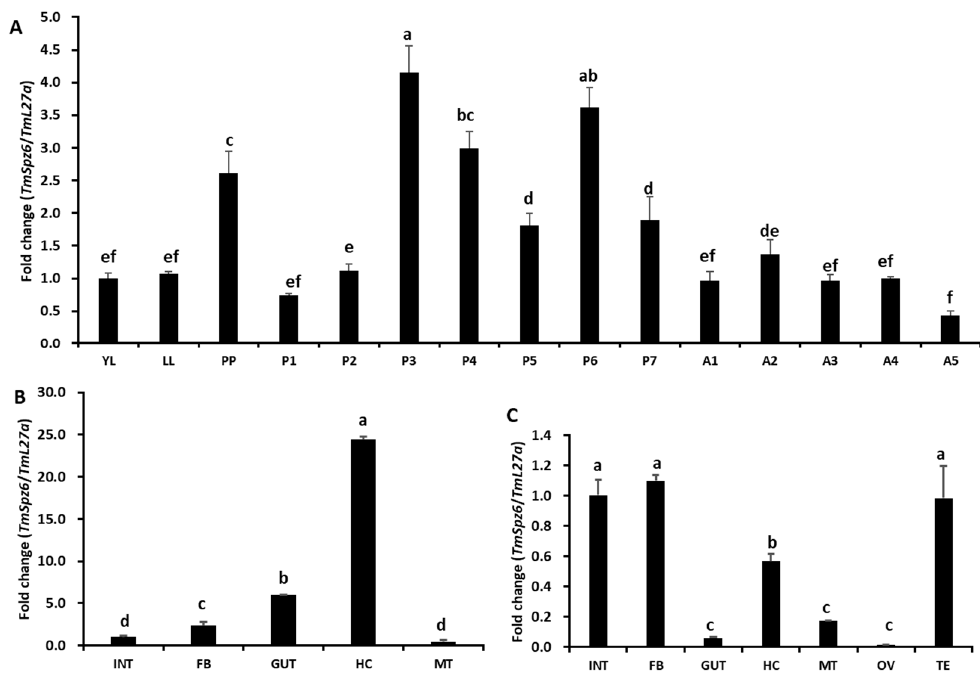
Figure 3. Developmental stage- and tissue-specific expression patterns of the TmSpz6 gene in T. molitor. TmSpz6 expression patterns across the developmental stages of T. molitor , including, young larvae (YL), late larvae (LL), pre-pupa (PP), 1–7-day-old pupae (P1–7), and 1–5-day-old adults (A1–5) were examined ( A ). For each sample, RNA extracted from 20 individuals was used to synthesis cDNA. The results indicate that TmSpz6 expression gradually increased from the young larval to pre-pupal stage. In the pupal stage, the highest expression was observed in 4-day-old pupae. In adults, there was no considerable di ff erence in expression in 2–5-day-old adults. The tissue-specific expression patterns of TmSpz6 were also assessed in late larvae ( B ) and 5-day-old adults ( C ). The hemocytes (HC), gut, fat body (FB), Malpighian tubules (MT), and integument (INT) (for late instar larvae and adults), as well as the testes (TE) and ovaries (OV) (for adults), were dissected and collected from 20 late larvae and 5-day-old adults. T. molitor 60S ribosomal protein L27a ( TmL27a ) served as an endogenous control to normalize RNA levels between samples. The data are the means of three biological replicates. The asterisks indicate significant di ff erences ( p ≤ 0.05).